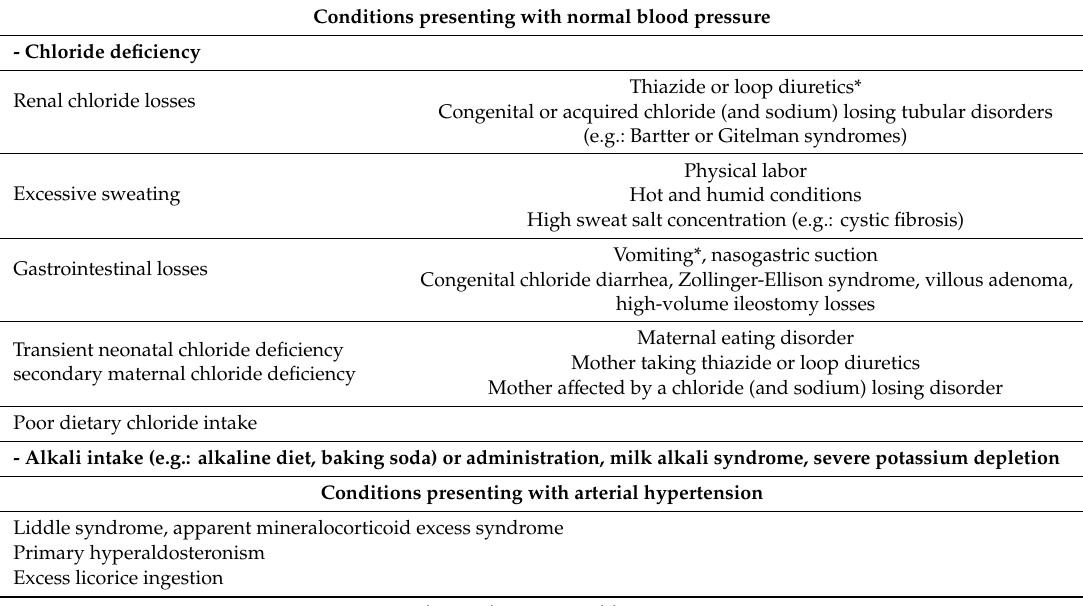
Figure 2. Sketch depicting the corrective response of the sodium-independent chloride–bicarbonate exchanger pendrin to metabolic alkalosis induced by an alkaline diet (upper panel), or by dietary chloride deficiency (lower panel). In order for pendrin to secrete bicarbonate and, therefore, correct alkalosis, chloride must be reabsorbed. Thus, sufficient distal tubule chloride delivery is critical for bicarbonate secretion (as in alkaline diet, upper panel). However, chloride depletion (and reduced effective blood volume) decreases distal chloride delivery, and this reduces pendrin-mediated bicarbonate secretion (and chloride reabsorption), thereby “maintaining” metabolic alkalosis (lower panel). Table 1. Common causes of metabolic alkalosis (and hypokalemia) associated with normal or elevated blood